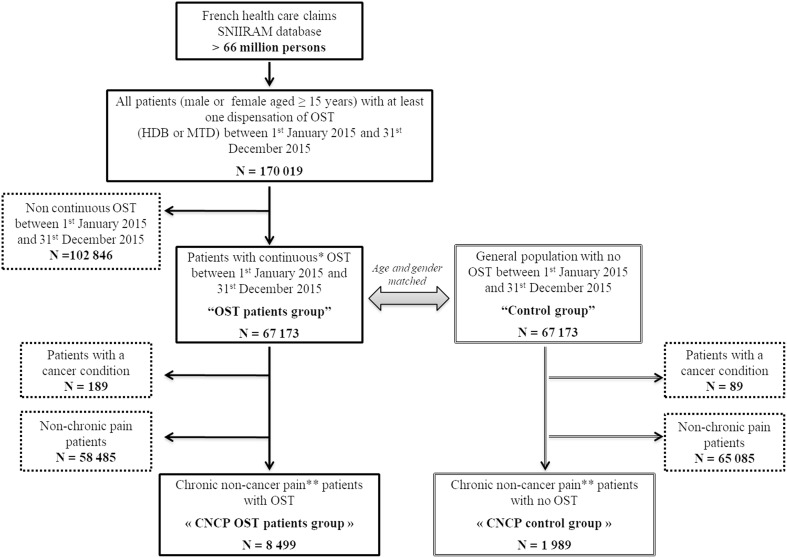
Flow chart. OST, opioid substitution treatment; HDB, buprenorphine; MTD, methadone; CNCP, chronic non-cancer pain; SNIIRAM, Systeme National d'Infonnations Inter-Regimes de I'Assurance Maladie. *Interval between two consecutive dispensations ≤35 days for HDB and MTD capsule and ≤l8 days for MTD syrup. **Patients treated continuously for at least 3 months with opioid analgesics and non-opioid analgesics (interval between two consecutive analgesic dispensations ≤45 days).